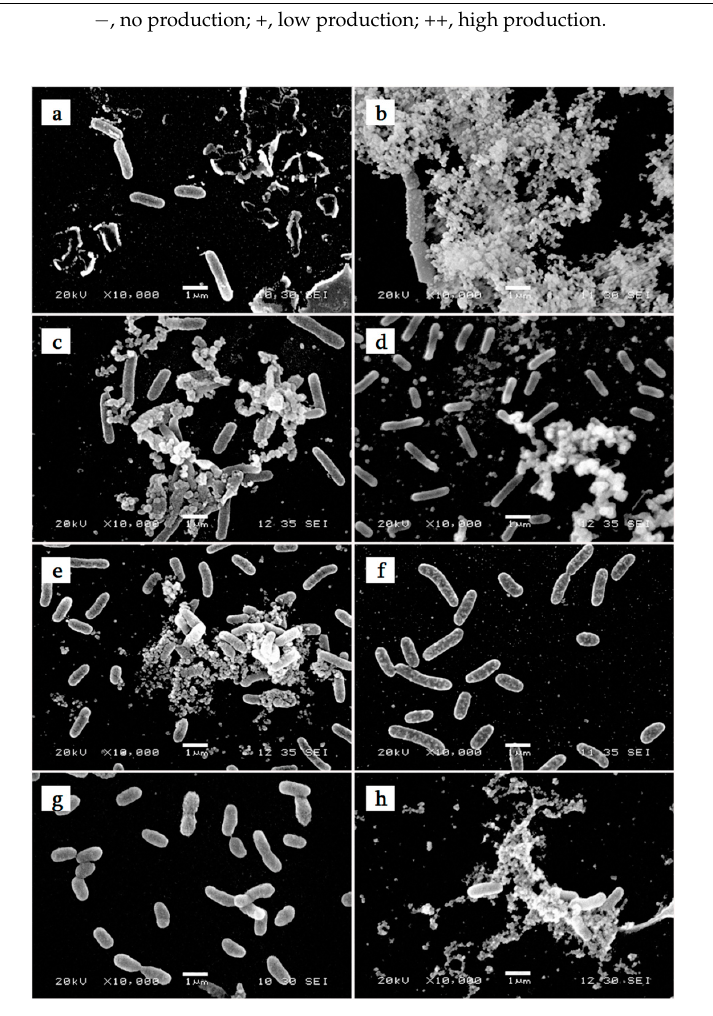
Figure 1. SEM photomicrographs of marine bacteria after 3 h adhesion on glass slides (ASW medium, 20 °C). ( a ) Paracoccus sp. 4M6, ( b ) Bacillus sp. 4J6, ( c ) Pseudoalteromonas sp. 5M6, ( d ) Polibacter sp. TC5, ( e ) Pseudoalteromonas lipolytica TC8, ( f ) Shewanella sp. TC11, ( g ) Shewanella sp. PVV6, ( h ) Shewanella sp. MVV1.